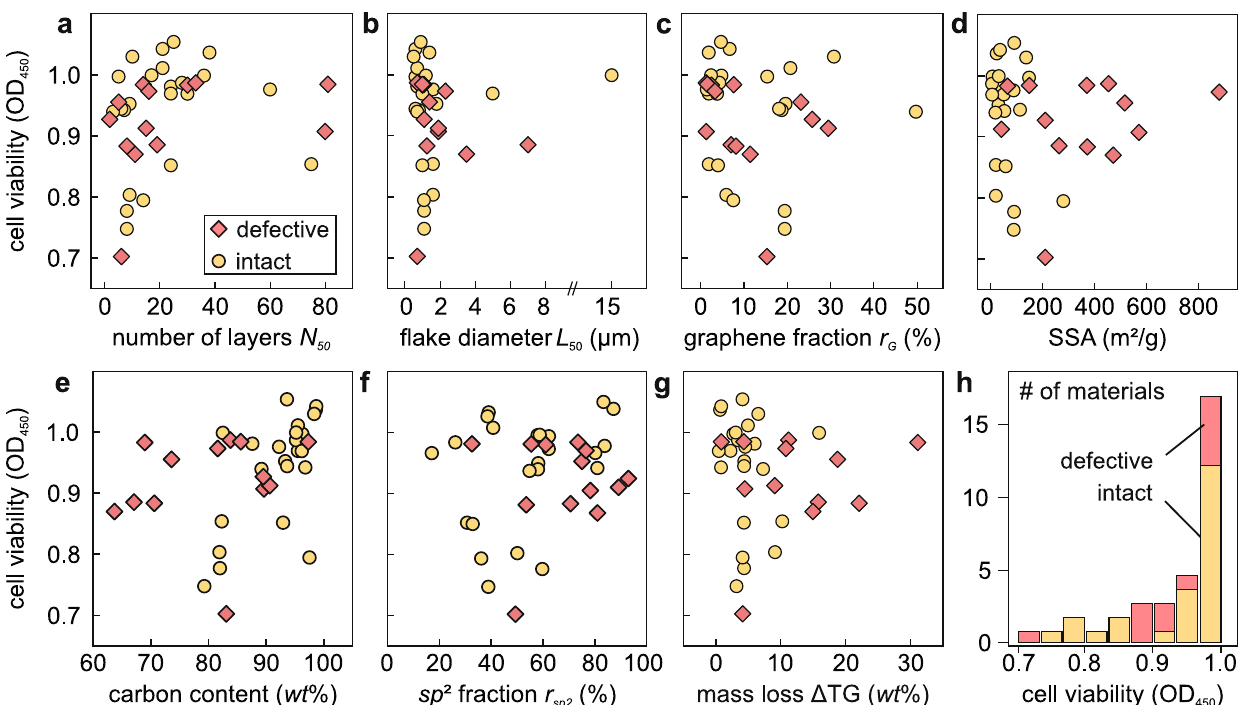
Fig. 4 Cell viability is simultaneously affected by several properties of commercial graphene materials. Correlation analysis of WST-1 (cell viability) stimulated by nominal graphene materials (NGM ’ s) at 10 µg/ml concentration: a median of number of layers N 50 . b median fl ake diameter L 50 . c graphene content r G . d speci fi c surface area (SSA) calculated by the Brunauer, Emmett, and Teller method (BET). e carbon content wt %( C ). f Fraction of sp 2 bounded carbon, r ( sp 2 ). g thermogravitometric mass loss Δ TG in the 100 °C to 800 ° C temperature range. h representation of number of intact or defective NGMs to varying levels of %cytotoxicity. Intact graphene samples, NGM int , are represented by yellow circles and defective graphene samples, NGM def , are shown as red diamonds. The combined Spearman ’ s correlation ( r scom ) and the signi fi cance ( p -value) for each graph are presented in Table 1.